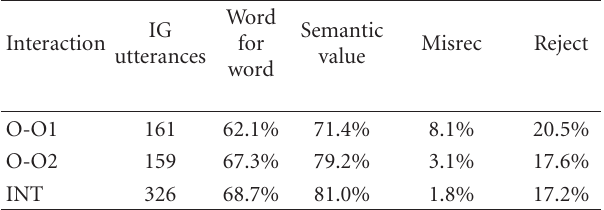
Table 5 details the category types for the